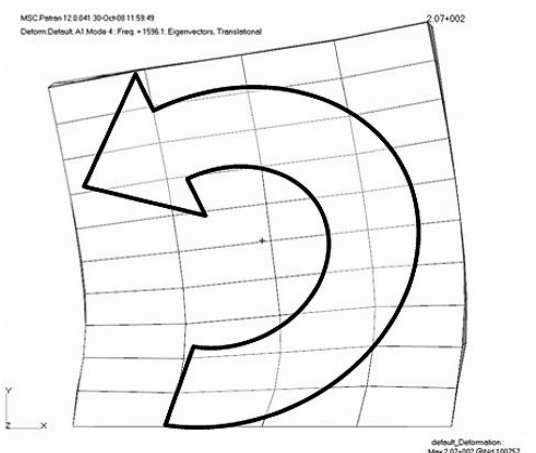
Fig. 7. TDA 3rd mode: 813 Hz – Y Rotation.